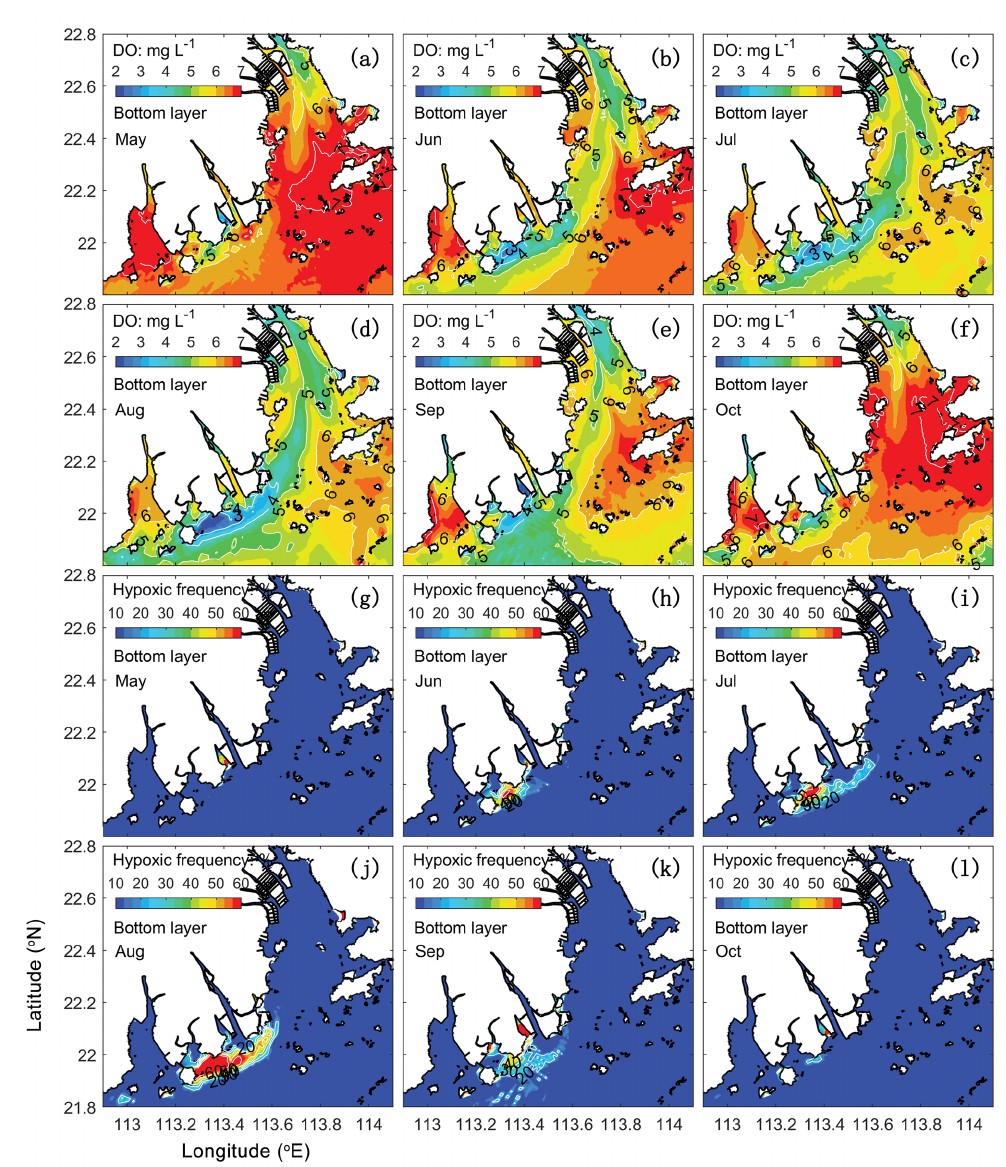
Figure 5. Spatial distributions of bottom DO (a–f) and hypoxic frequency (g–l) during May–October. Hypoxia is defined as DO concentration below 3mgL − 1